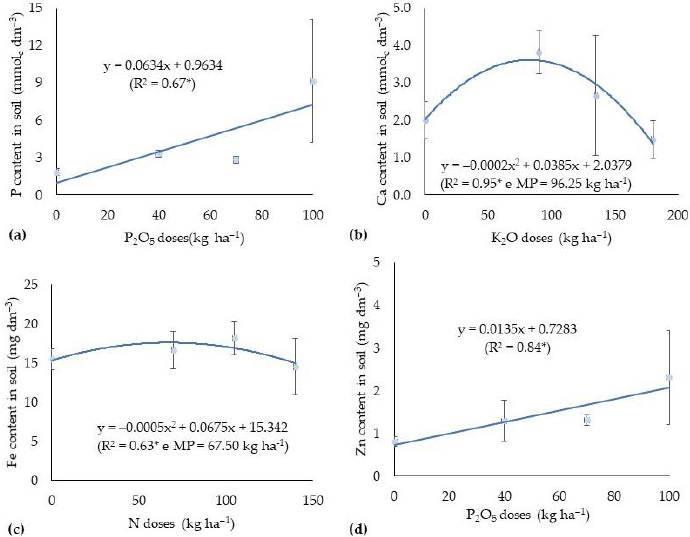
Figure 2. ( a ) Soil P content (0–20 cm) as a function of residual P 2 O 5 dose. ( b ) Soil Ca content (0–20 cm) as a function of residual K 2 O dose. ( c ) Soil Fe content (0–0.20 m) as a function of residual N dose. ( d ) Soil Zn content (0–0.20 m) as a function of residual P 2 O 5 dose. Each point located on each graphic is a mean of five replications. * = significant at 5% level by F test.